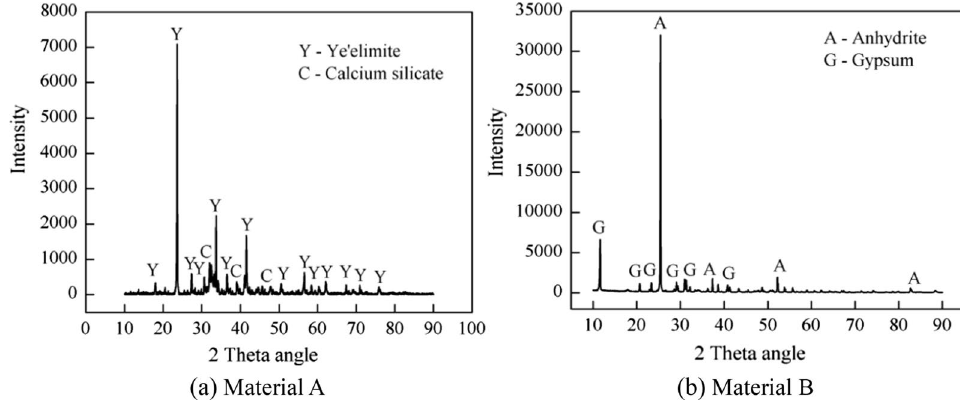
Fig. 4 X-ray diffraction pattern of high-water